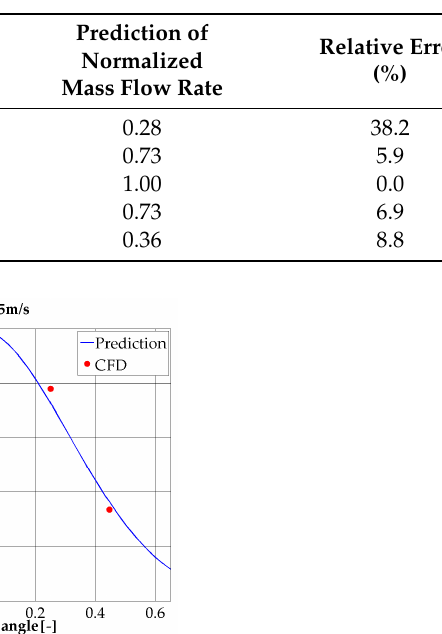
Table 2. Percentage relative error between CFD and empirical normalized airflow rate for 2.5 m / s.